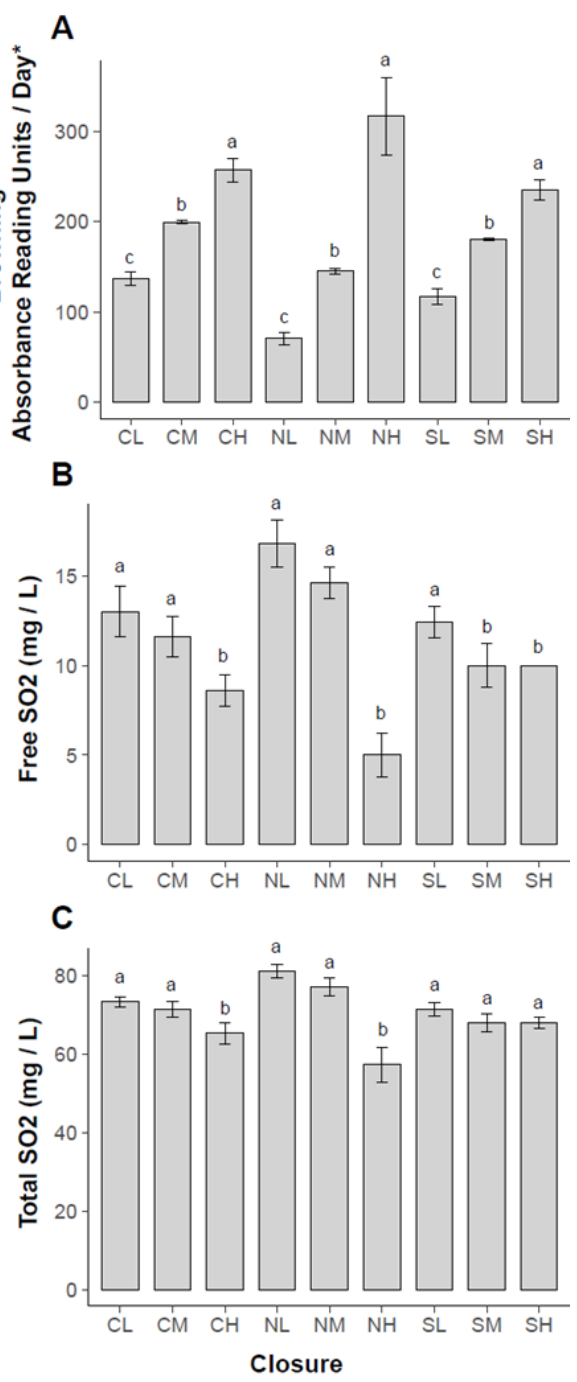
Figure 2. ( A ) Average browning (Abs 420 nm) (* all browning levels were magnified by 1 × 10 6 ), ( B ) Free SO 2 ,and ( C ) Total SO 2 levels of bottles chosen for QDA sensory analysis and their significant differences within closure type. n = 5 bottles selected per closure/browning level; rows/bars sharing the same letter (a, b, or c) are not significantly different within closure group ( p ≤ 0.05)